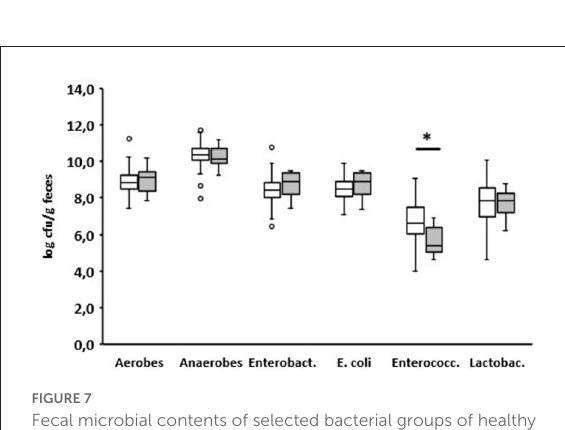
FIGURE7 Fecal microbial contents of selected bacterial groups of healthy calves on day 7 after birth. White boxes: values of calves that remain healthy; gray boxes ( n = 101): values of calves with diarrhea starting the next day ( n = 8) (Enterobact., Enterobacteriaceae ; Enterococc., Enterococcus spp.; Lactobac., Lactobacillus spp.; Wilcoxon test, * p <